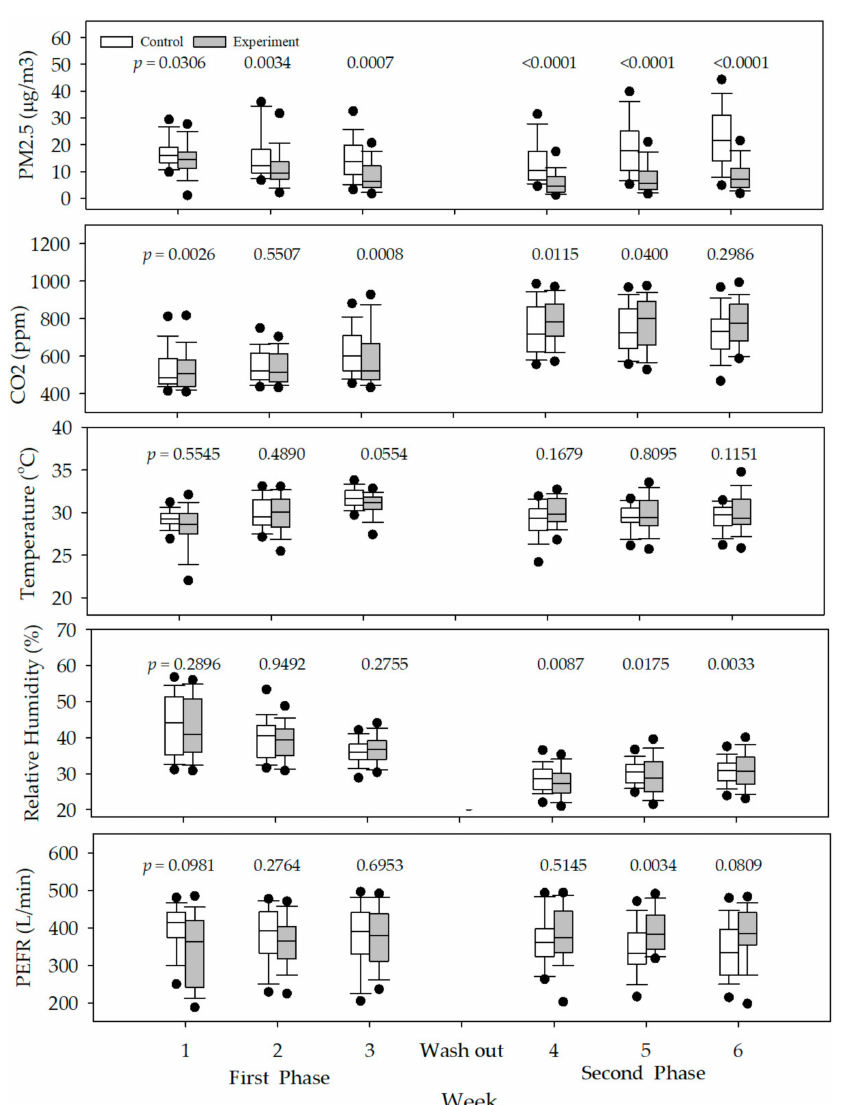
Figure 2. Distributions of daily indoor particulate matter < 2.5 µ m (PM2.5), temperature, relative humidity, CO 2 , and peak expiratory flow rate (PEFR) measurements per week during the intervention period. Significant di ff erence of the distribution between the two groups was evaluated using Mann–Whitney U test. We provided p -values on the